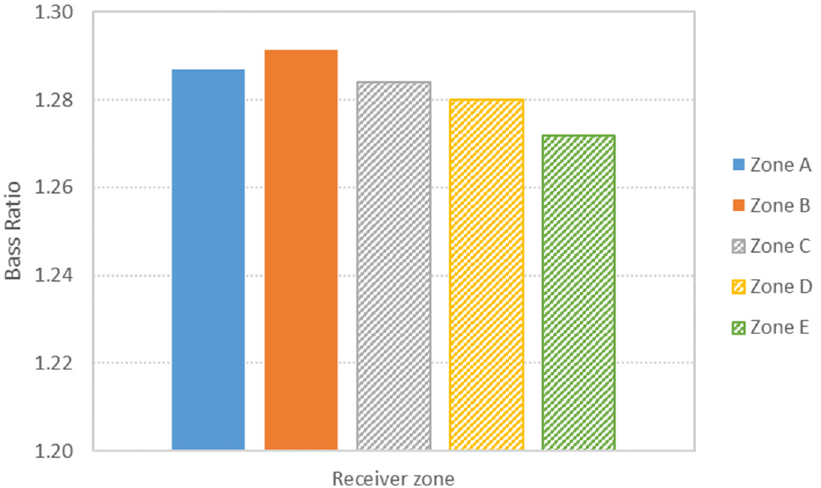
Figure 14. Bass ratio obtained in the auditorium, when the variable acoustic solution provides min- imum absorption (configuration R), by